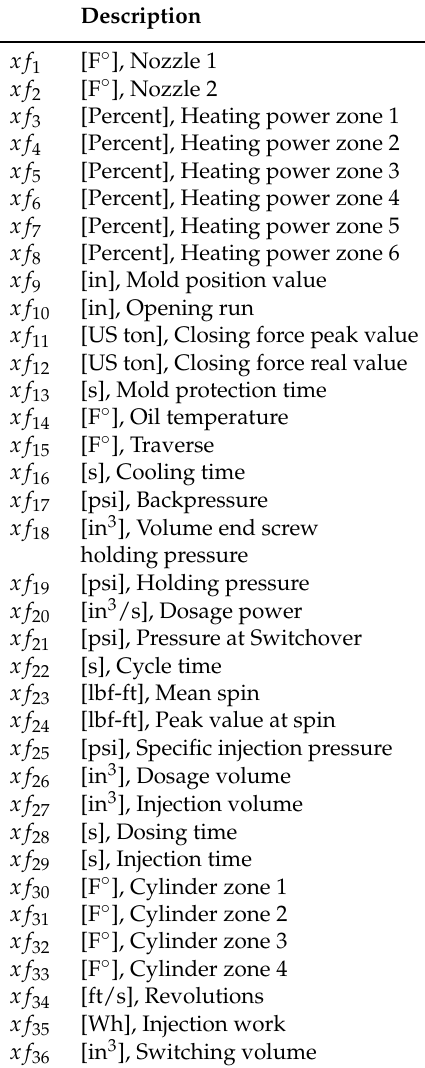
Table 1. Variables